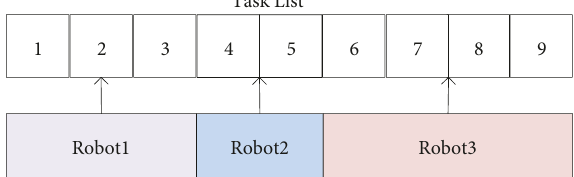
Figure 2: Example diagram of task assignment.